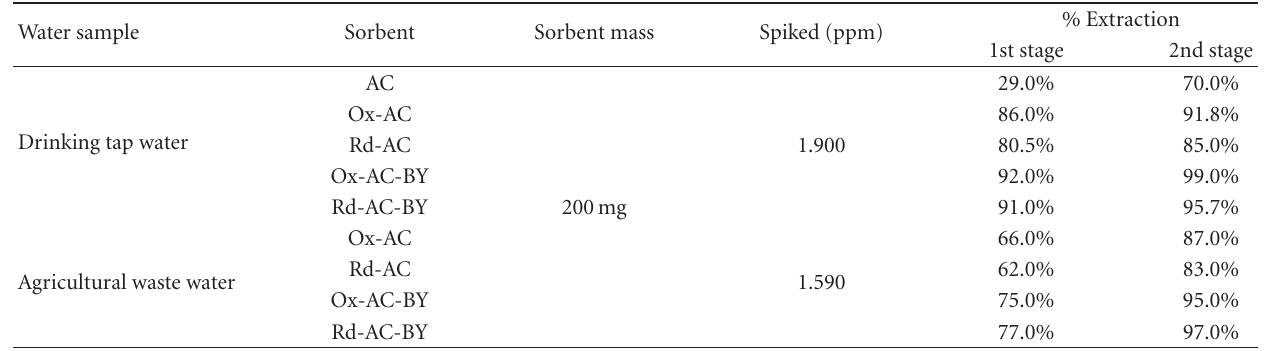
Table 6: Removal of lead from real water samples by modified AC.